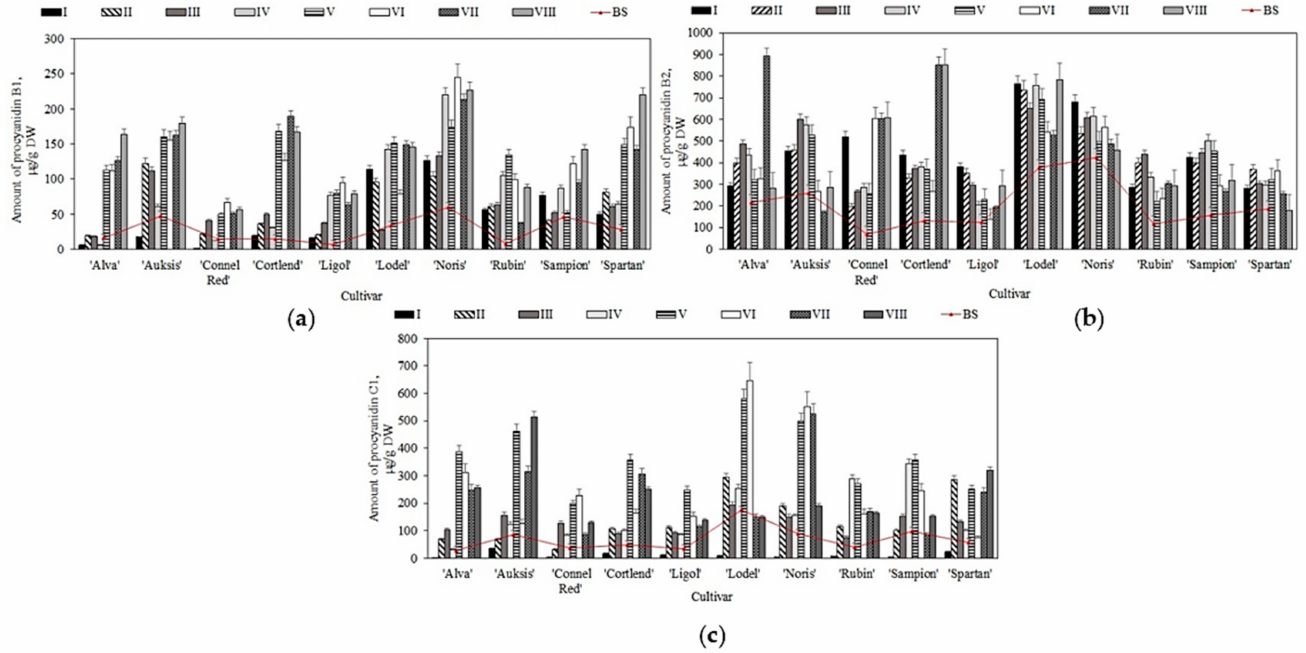
Figure 3. Changes in the amount of oligomeric flavan-3-ols in whole apple samples before and after storage in controlled atmosphere: ( a ) Changes in the amount of procyanidin B1; ( b ) Changes in the amount of procyanidin B2; ( c ) Changes in the amount of procyanidin